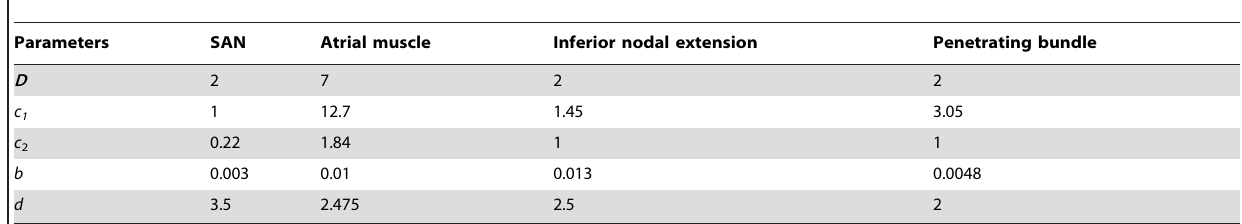
Table 1. Parameters for the Fitzhugh-Nagumo model for the SAN, atrial muscle and AVN.